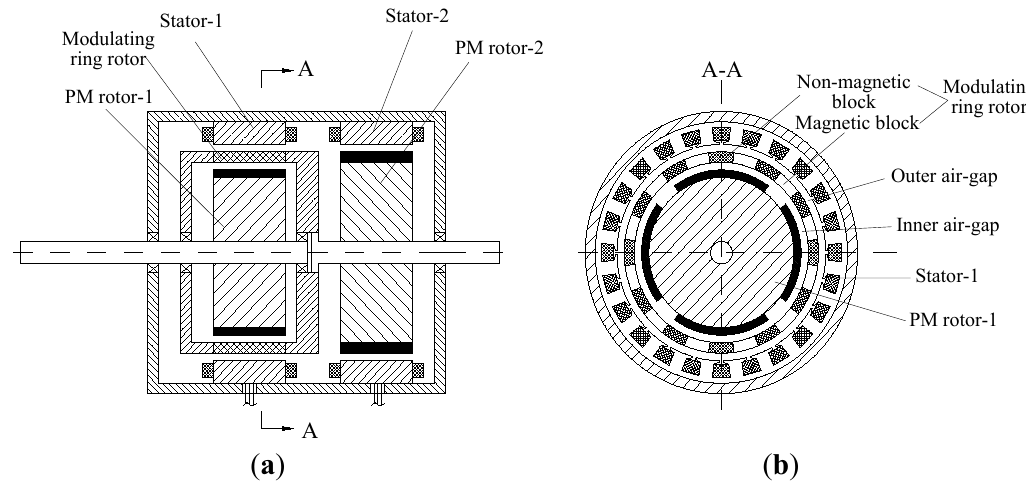
Figure 2. ( a ) The flux-modulated CS-PMSM; ( b ) The cross section of the brushless